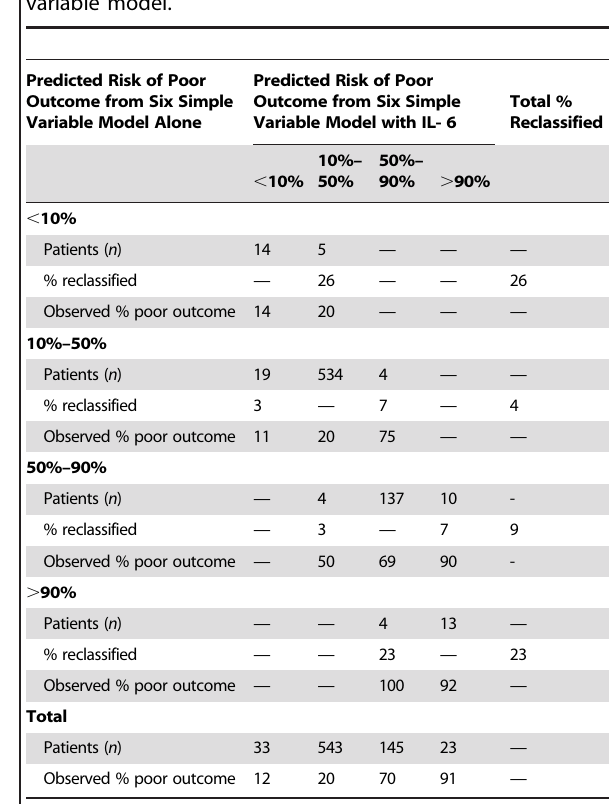
Table 4. Risk stratification tables to assess the clinical significance of added predictive value of IL-6 to the six simple variable model.